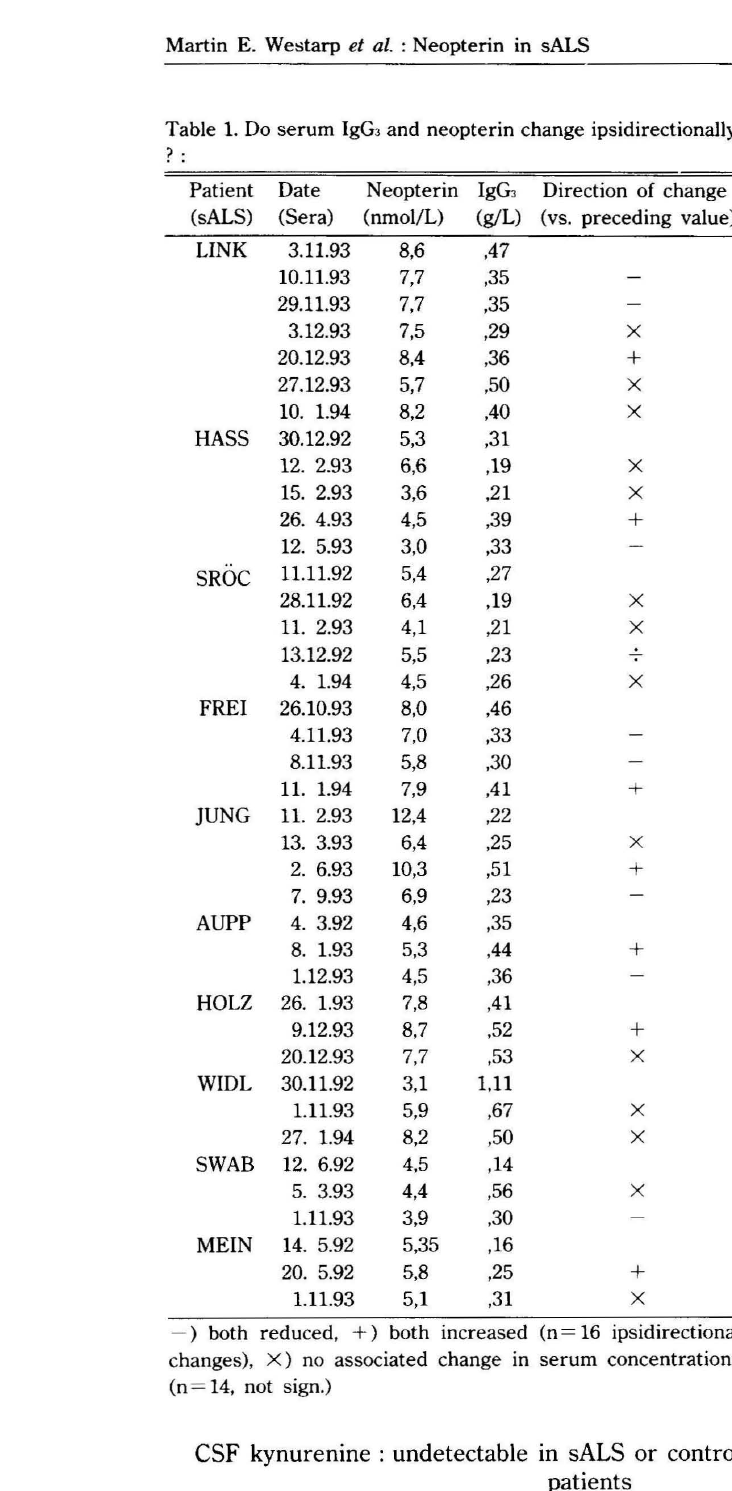
Table 1. Do serum IgG3 and neopterin change